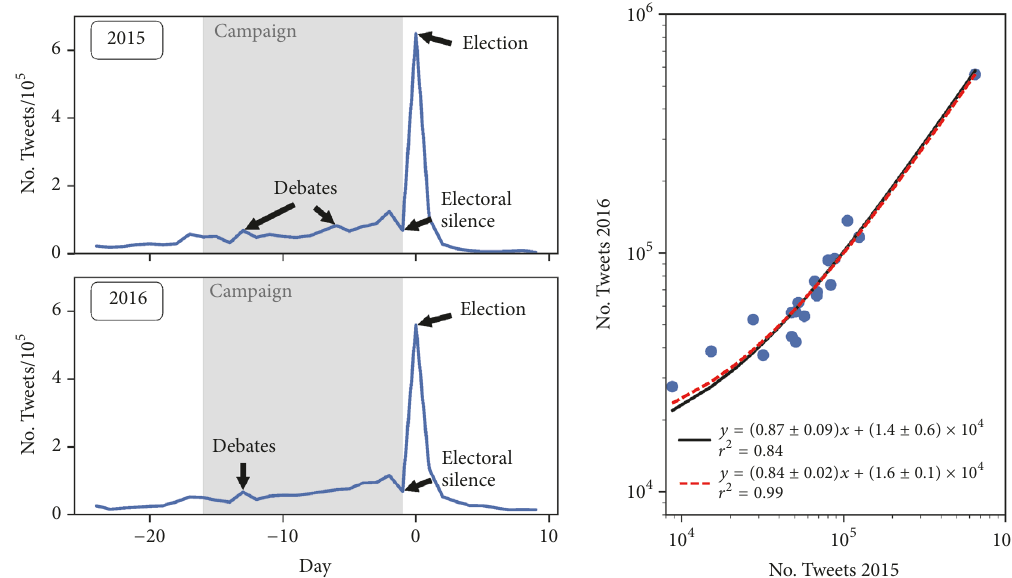
Figure 2: Left panels: time series of aggregated user activity per day for the 2015 (top) and 2016 (bottom) elections. The shadowed region corresponds to the days of electoral campaign. Right panel: linear regression between the activity time series of both elections. The lines correspond to the linear fits of the data including the day of the elections (red dashed line) and excluding it (black continuous line).